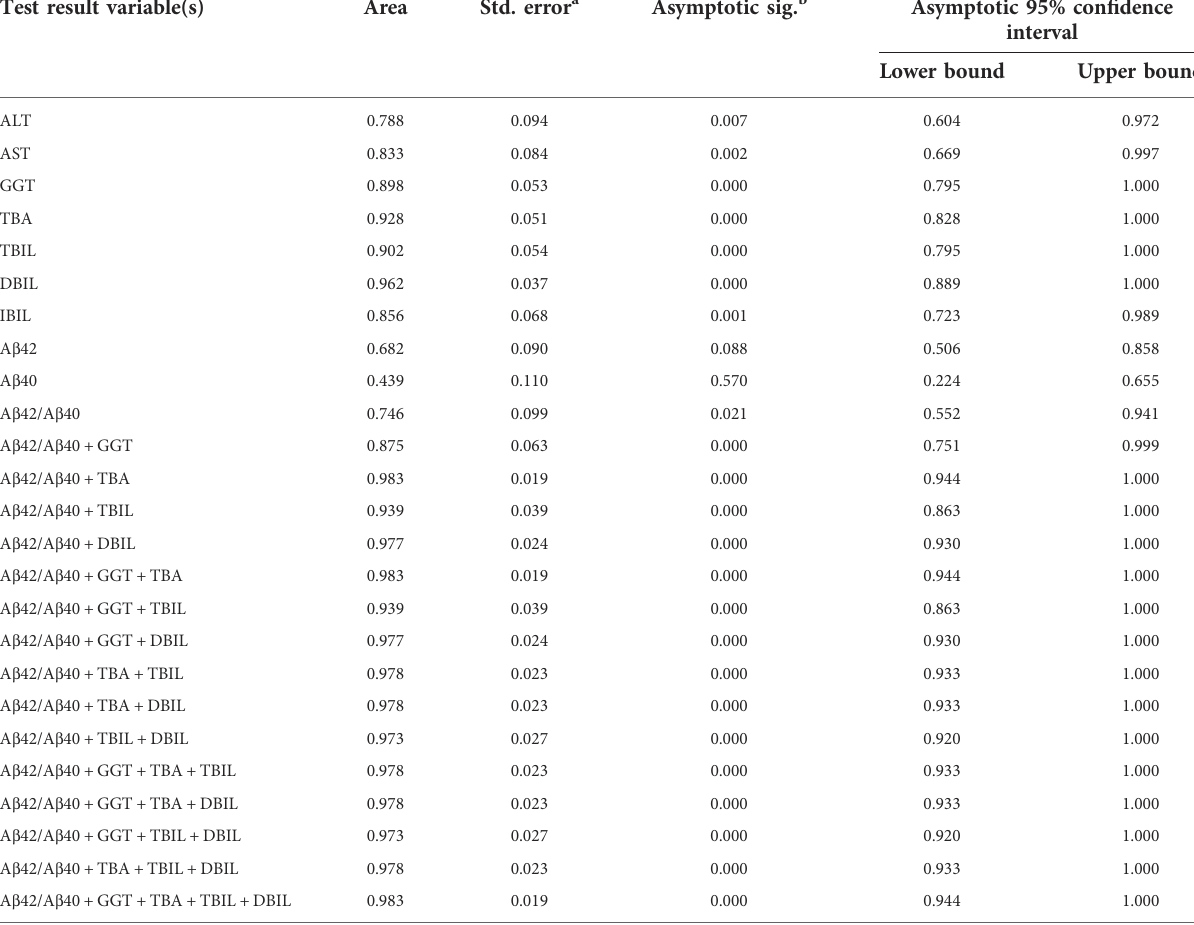
TABLE 3 Area under curve of A β 42, A β 40, A β 42/A β 40, and hepatic function parameters for the diagnosis of cholestasis. Test result